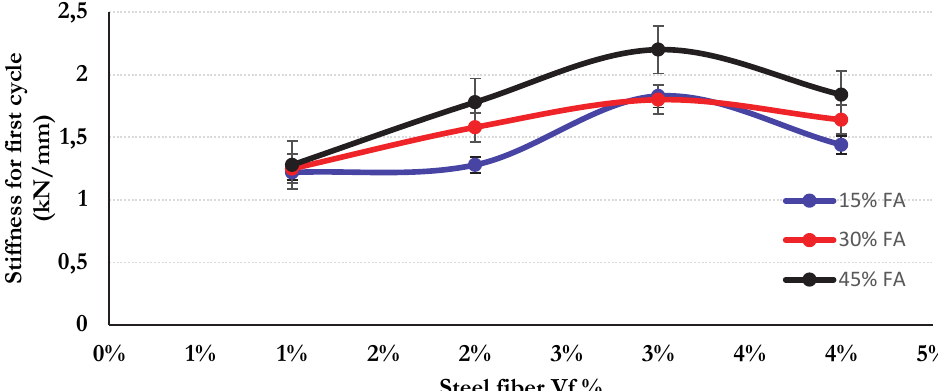
Figure 11: The effect of steel fiber volume fraction and fly ash on the stiffness for the first